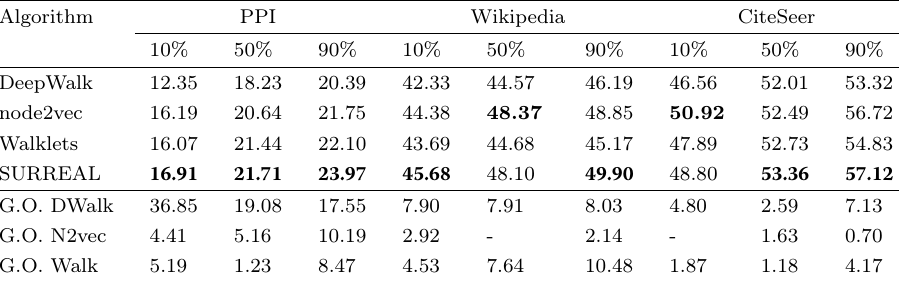
Table 2 A brief description of evaluation datasets Dataset